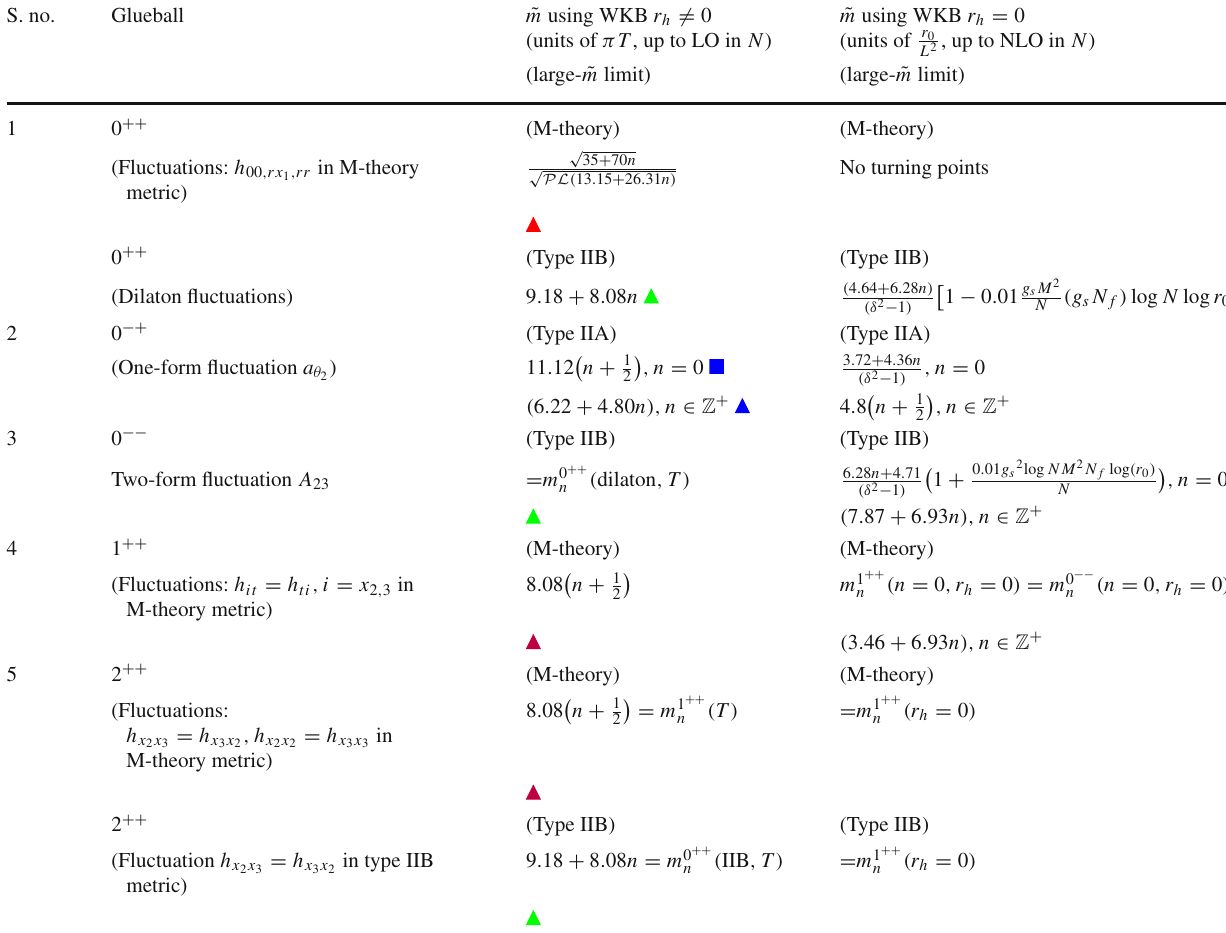
N ); the colored triangles/square in the third column correspond to the fromtypeIIB,IIAand L 2 colored triangles/square that appear in Fig. 2 in the combined plot of L 2 r h (cid:10)= 0 supergravity calculations of glueballs